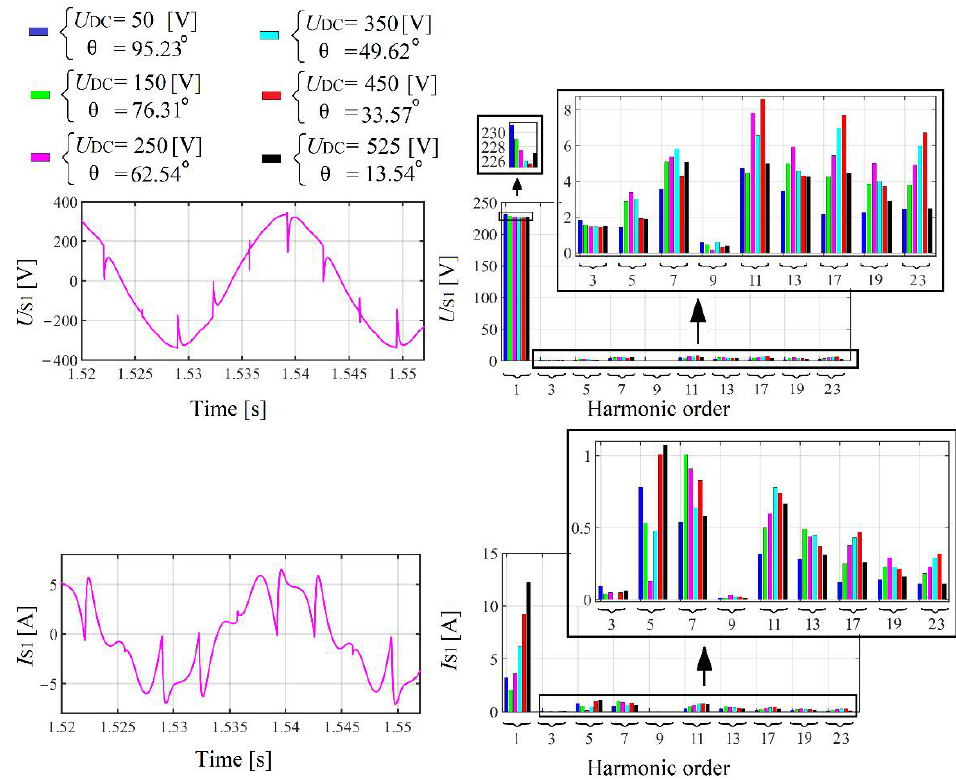
Figure 46. Waveforms and spectrums of grid current and voltage.